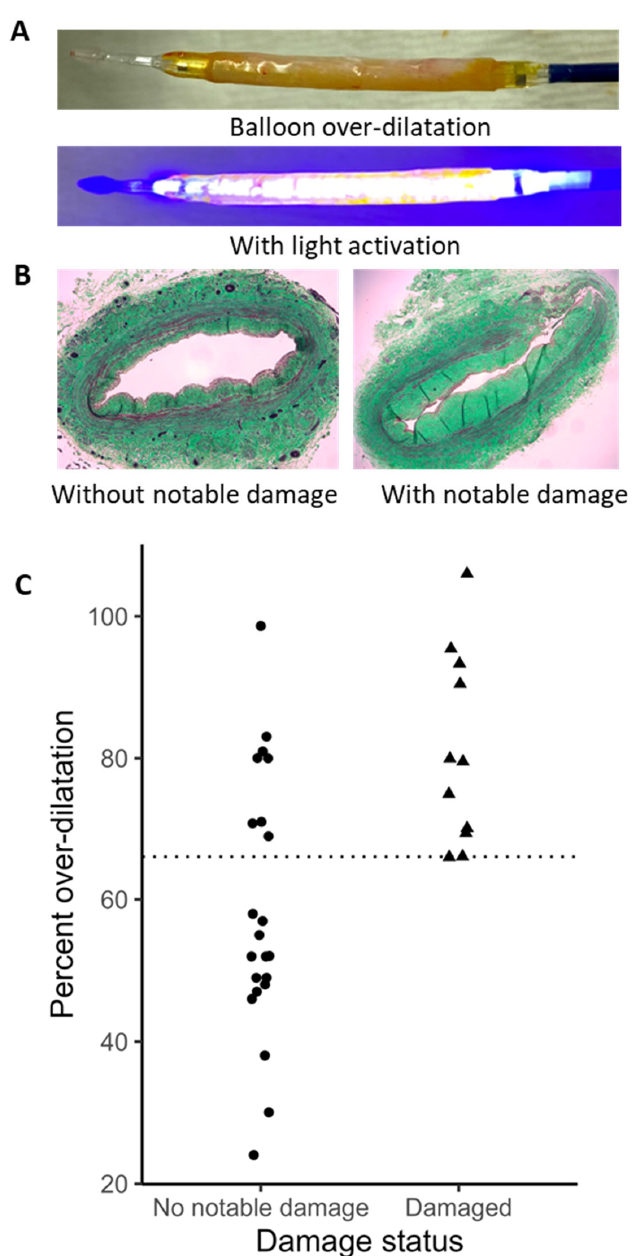
Figure 5. Human Vein Treatment with VRS-AVF Ex Vivo. Panel A demonstrates representative human vein segments cannulated and dilated by the VRS-AVF device. The yellowish color is a result of the 10-8-10 Dimer coat on the balloon, which diffuses into the venous wall during treatment. The lower picture of panel ( A ) shows the light activation phase during balloon dilatation at a distended lumen size. Panel ( B ) demonstrates two histological cross sections stained with Masson’s staining. The image on the left-hand side illustrates an intact vein, and the right-hand side illustrates a damaged vein histological cross section as a result of the treatment with balloon dilatation. Panel ( C ) summarizes results of all 33 human vein segments studied. The dotted line at 66% represents the maximum dilatation the vein can accommodate before damage of the vessel wall can be seen in histological images. Important to note that some veins resisted even 100% dilatation without visible